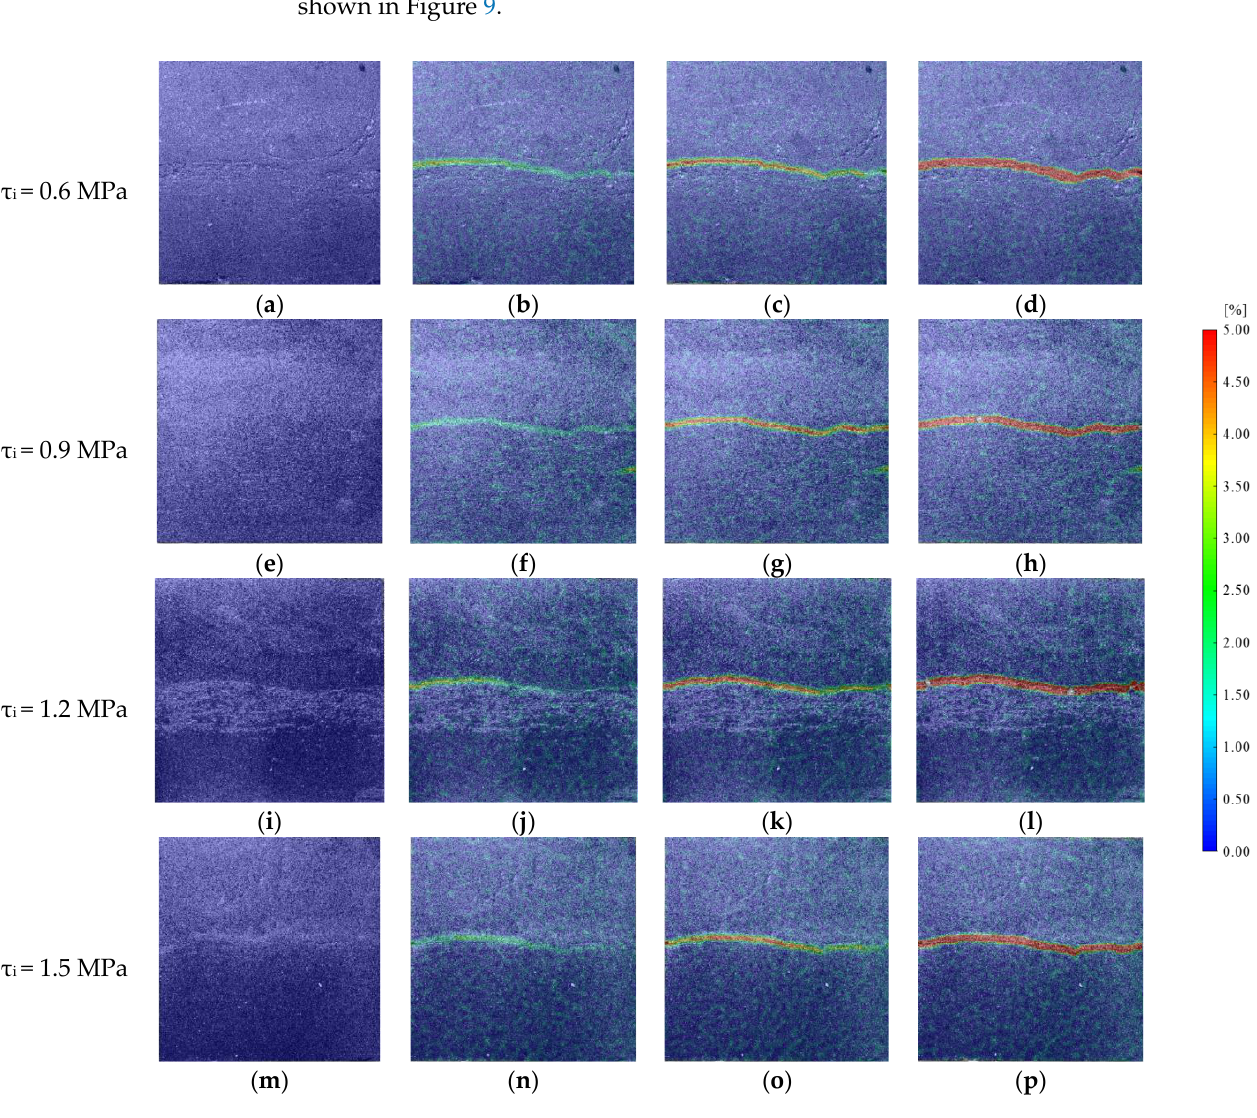
Figure 7. Principal strain field of specimens at different initial shear stress. ( a ) Frame 0. ( b ) Frame 1458. ( c ) Frame 2793. ( d ) Frame 3481. ( e ) Frame 0. ( f ) Frame 1279. ( g ) Frame 2341. ( h ) Frame 3152. ( i ) Frame 0. ( j ) Frame 1120. ( k ) Frame 2016. ( l ) Frame 2947. ( m ) Frame 0. ( n ) Frame 942. ( o ) Frame 1846.